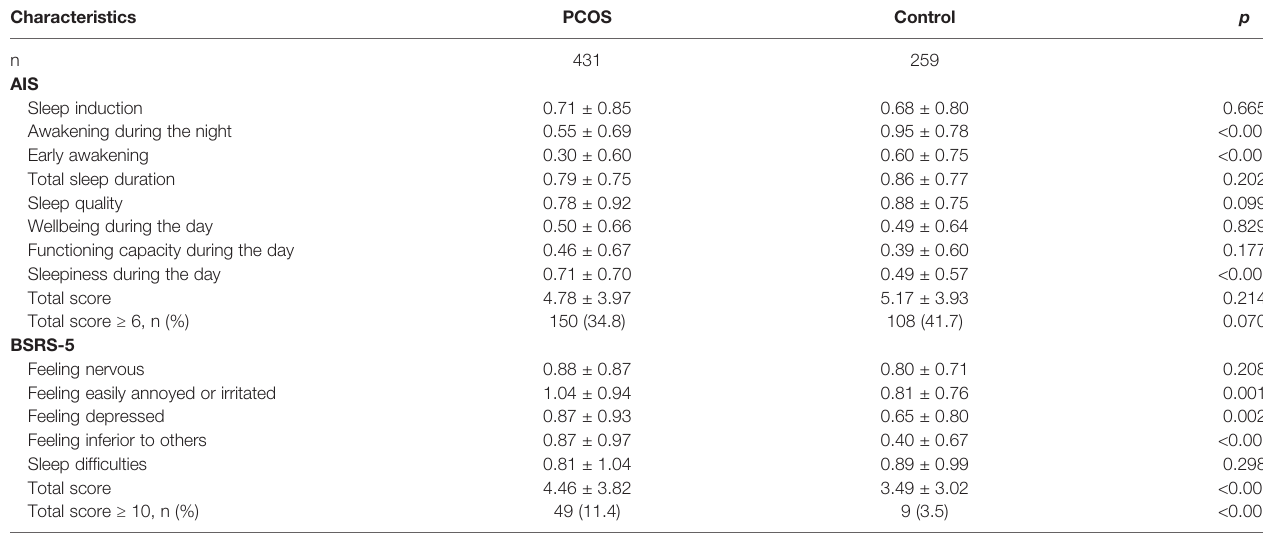
TABLE 2 | Sleep and psychological characteristics in the PCOS and control groups, based on the Athens Insomnia Scale (AIS) and the Brief Symptom Rating Scale (BSRS-5).